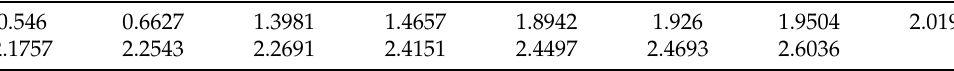
Figure 8. The Markov chains of S 0 ( 0.8 ) . Table 9. The first failure time in years of small electric